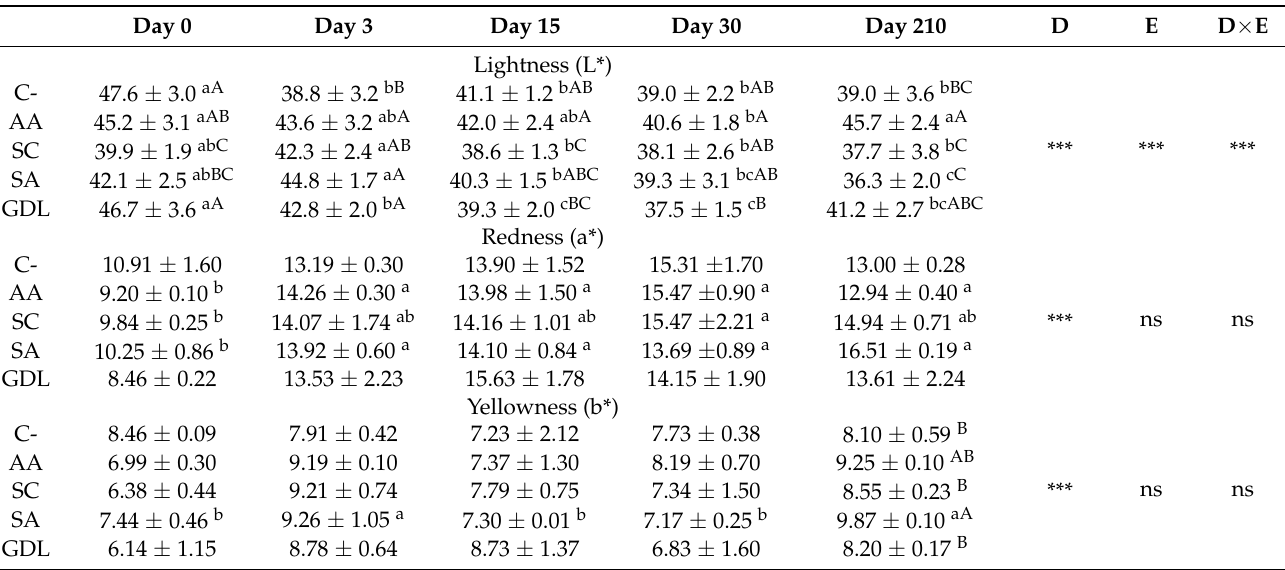
Table 2. Means and standard deviations of instrumental color for sausages manufactured with different reducing agents added during ripening and storage